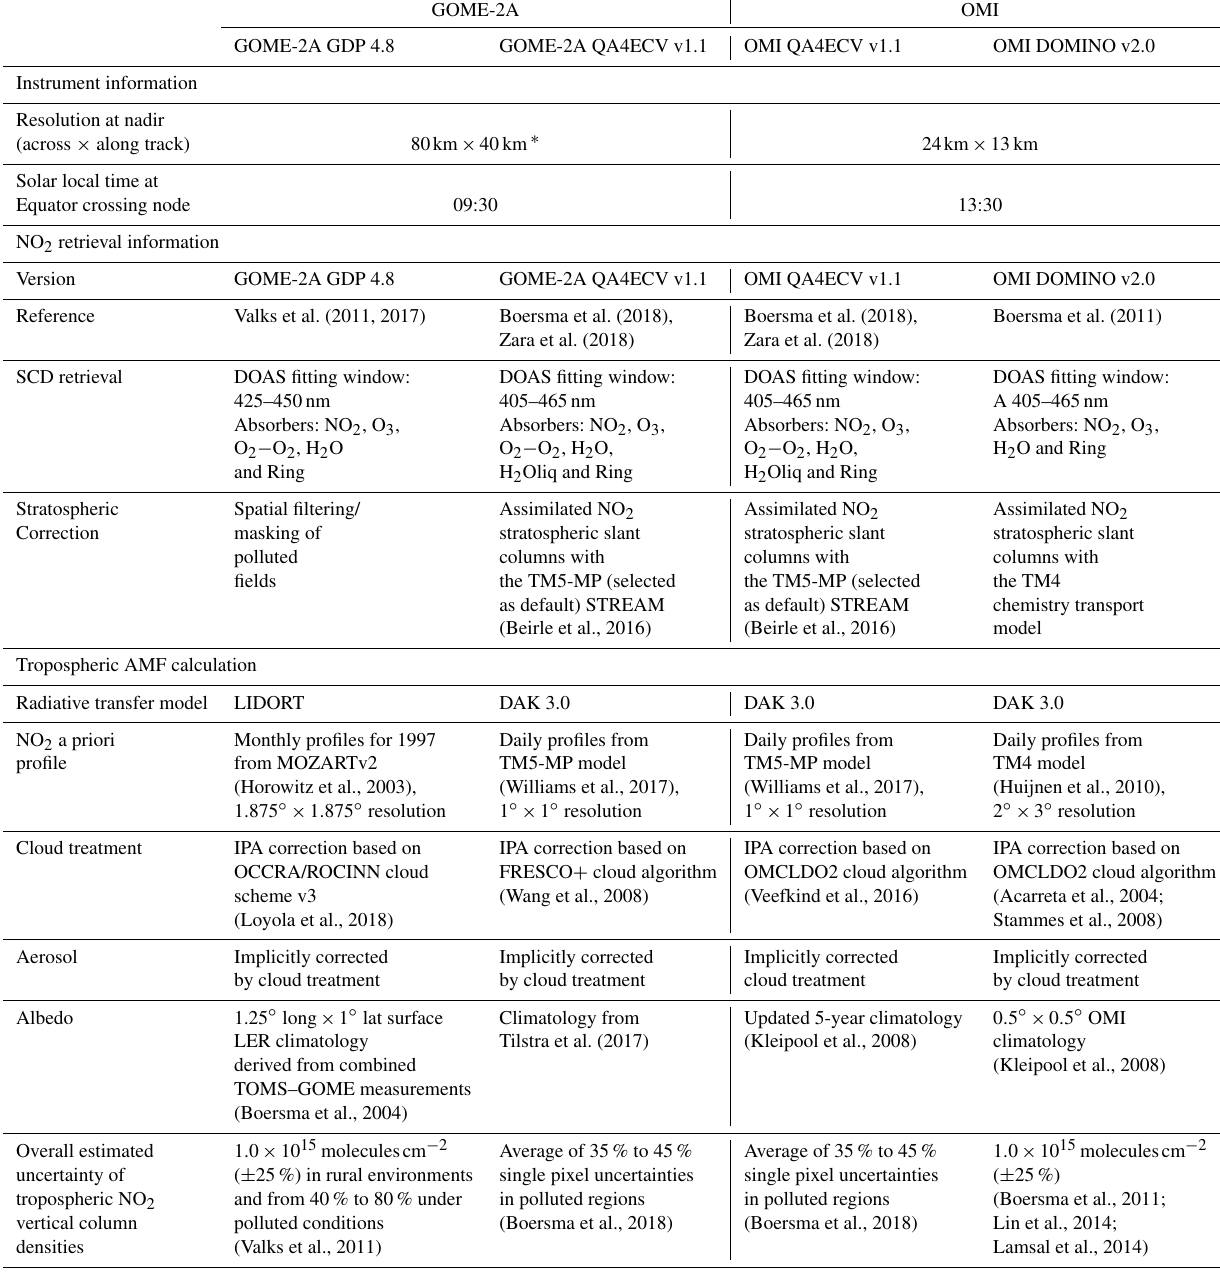
Table 1. Description of the satellite retrievals algorithms involved in this